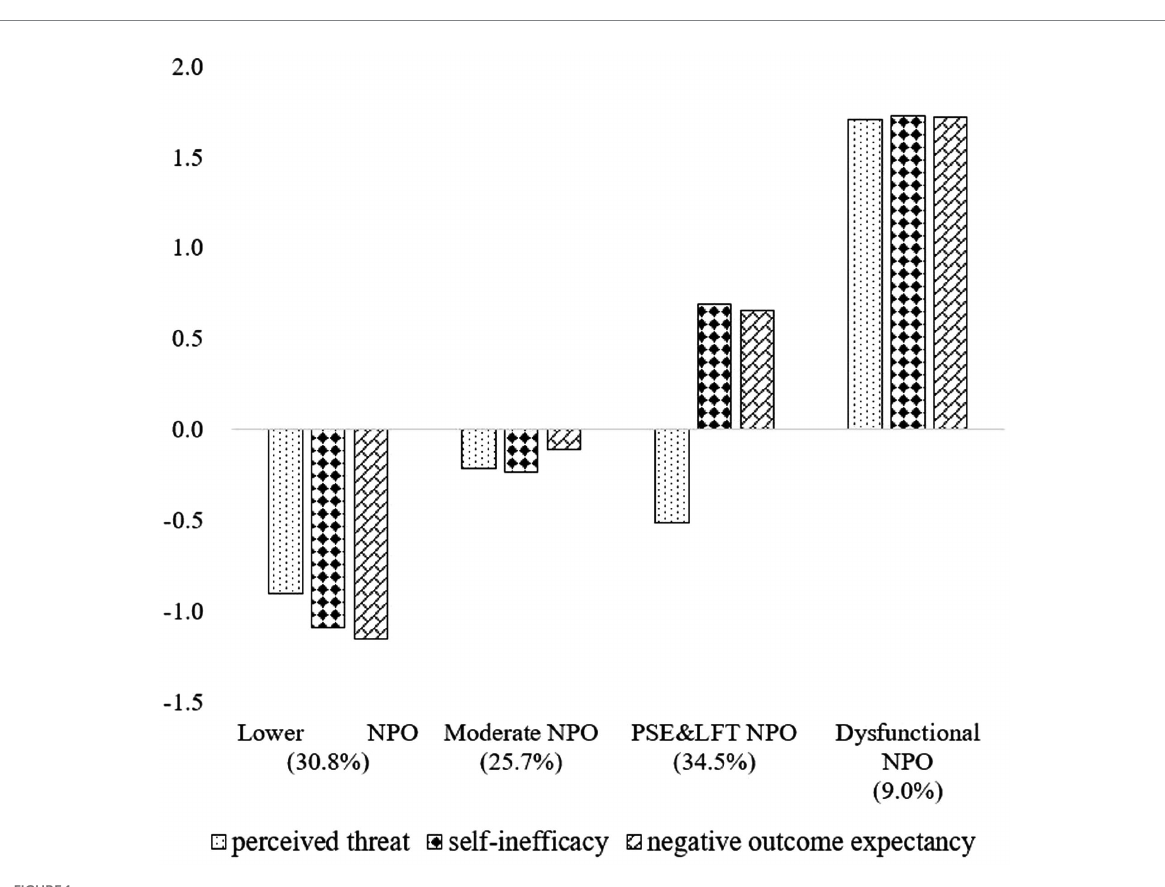
FIGURE 1 Means of the three domain-specific factors of NPOQ for the four-profile model. profile 1, lower NPO ; profile 2, moderate NPO ; profile 3, SI & NOE ; profile 4, dysfunctional NPO ; NPO, negative problem orientation; SI&NOE , self-inefficacy and negative outcome